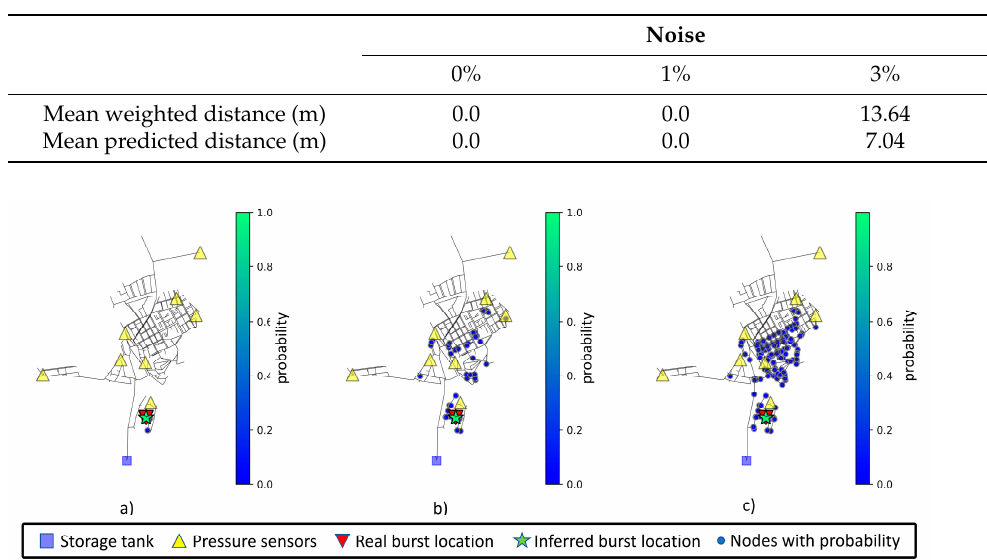
Table 13. Inference mean values for node 40, with noise.